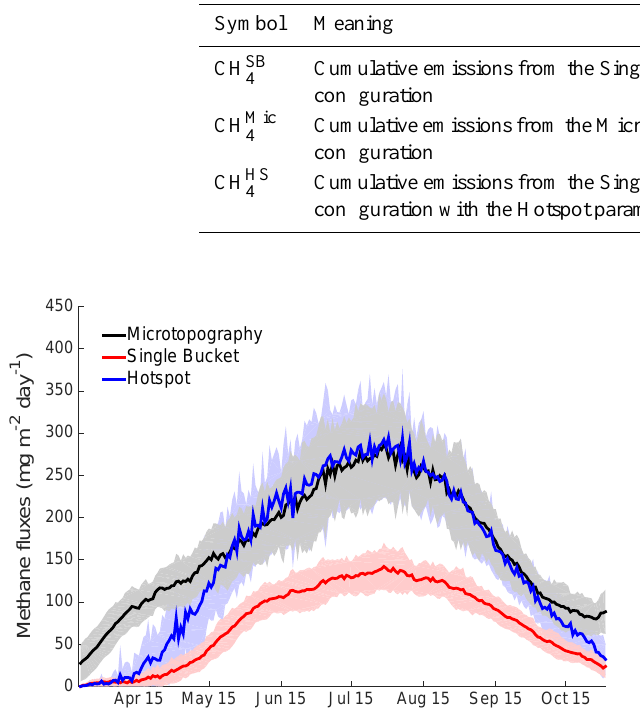
Figure 3. Methane emissions from the HH model coupled with the Walter and Heimann (2000) model. Solid lines are averages over 30 years (1976–2005) and shaded areas represent standard devia- tions. Emissions are computed using the HH model in the Micro- topography configuration (black line), in the Single Bucket config- uration (red line), and in the Single Bucket configuration with the Hotspot parameterization (blue